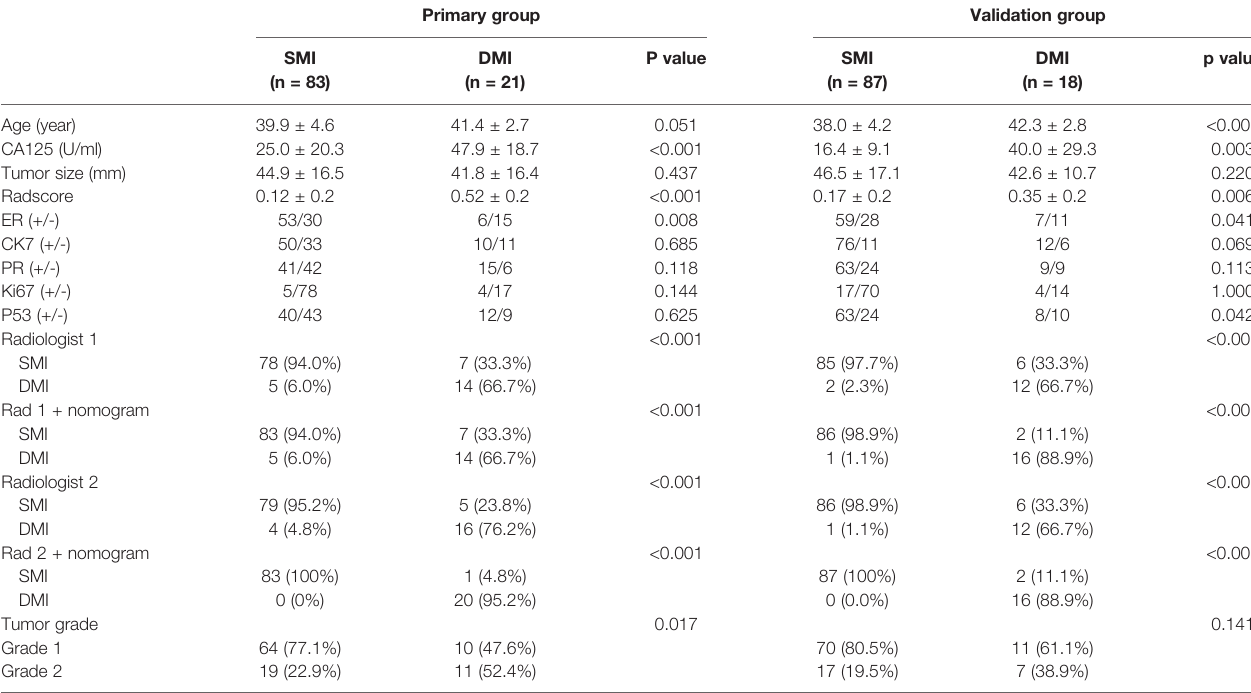
TABLE 1 | Clinicopathologic characteristics of the included grade 1/2 EEC